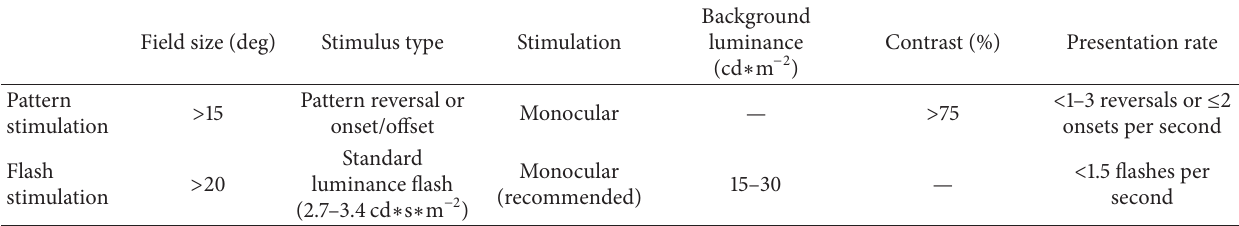
Table 2: Standards for VEP assessment according to